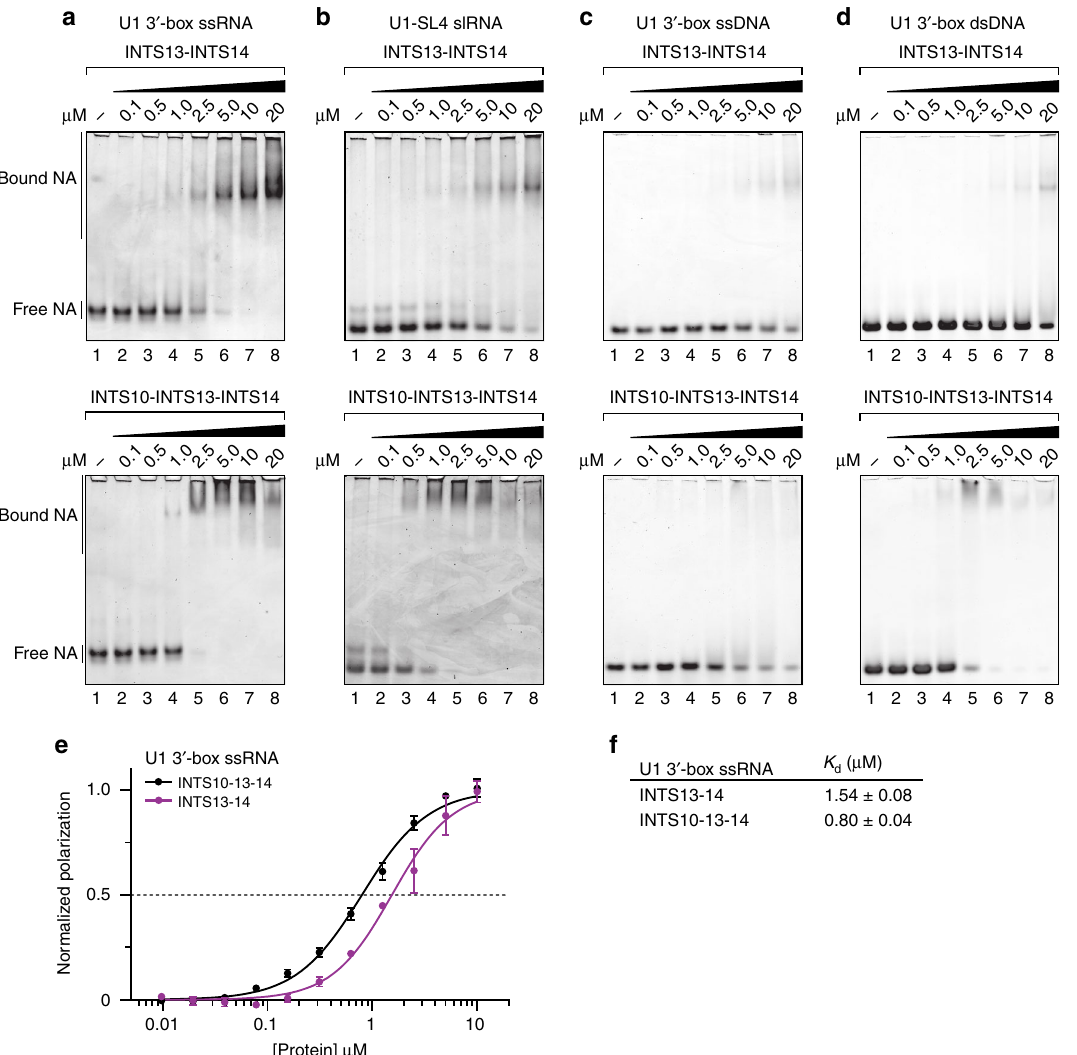
Fig. 4 The INTS10 – INTS13 – INTS14 complex binds nucleic acids with a preference for stem loop RNAs. a – d EMSAs of INTS13 – INTS14 (top panels) and INTS10 – INTS13 – INTS14 (lower panels) with U1 3 ′ -box ssRNA a , U1-SL4 dsRNA b , U1 3 ′ -box ssDNA c , and dsDNA d . Increasing protein concentrations were incubated with the respective nucleic acid, resolved on a native acrylamide gel and stained with a fl uorophore. e Fluorescence polarization of FAM- labeled U1 3 ′ -box ssRNA with INTS13 – INTS14 (purple) and INTS10 – INTS13 – INTS14 (black), respectively. Error bars indicate standard deviations from the mean of triplicate experiments. f Dissociation constants with standard error of means derived from fi tting data in e . Source data are provided as a Source Data fi